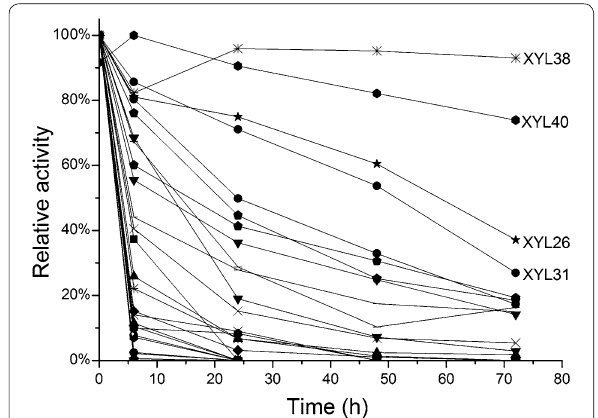
Fig. 1 Initial thermostability assay of xylanase-positive metagenomic library clones. Whole cell lysates of the positive metagenomic clones were incubated in a water bath at 60 °C for 3 days. Samples were taken at regular intervals and residual xylanase activity quantified using the EnzCheck xylanase